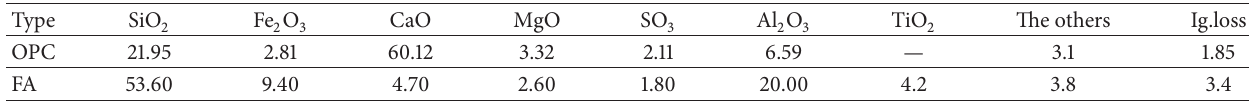
Table 2: Chemical compositions of binder (OPC and FA).